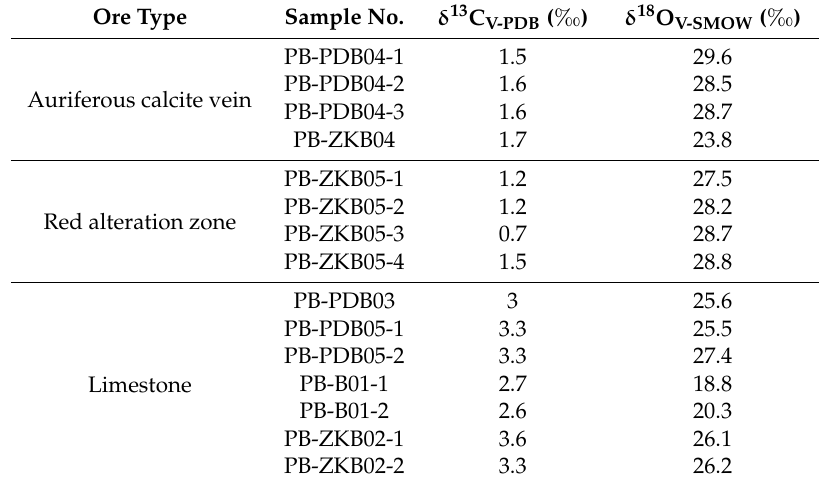
Table 3. Carbon and oxygen isotope compositions of calcite and limestone from the Phapon deposit. Ore Type Sample